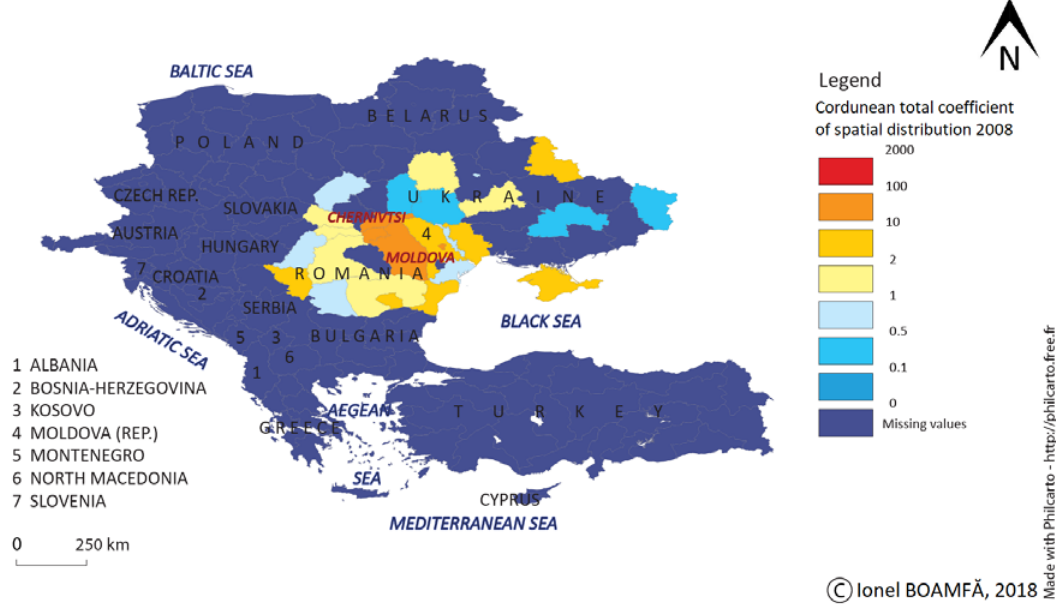
Figur e 2 . G eographical repartition of the anthroponym Cordunean . Coef. of spatial distribution The patronym Basarabean is also very rare – it has only 15 bearers. The meaning is related to its origin from B a sarabia . The small number can probably be explained by the late naming of the Prut- Nistru/Dniester space (which appeared, in its present - day extension, after the Tsarist occupation, in 1812). The highest values of the coefficient were registered